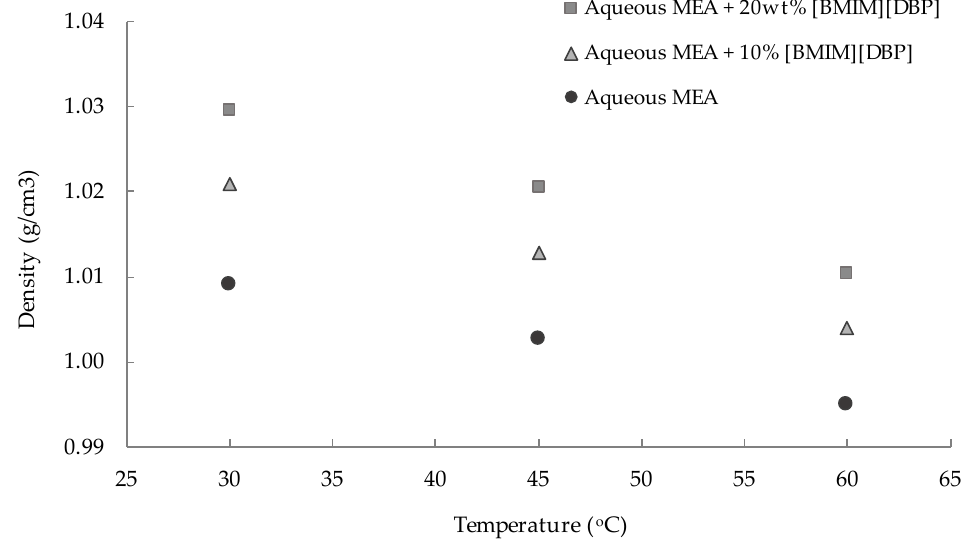
Figure 2. Density of aqueous 30 wt% MEA-(BMIM)(DBP) hybrid solvents containing different (BMIM)(DBP) concentrations at different temperatures (30 ◦ C, 45 ◦ C and 60 ◦ C) and at pressure of 1 atm.